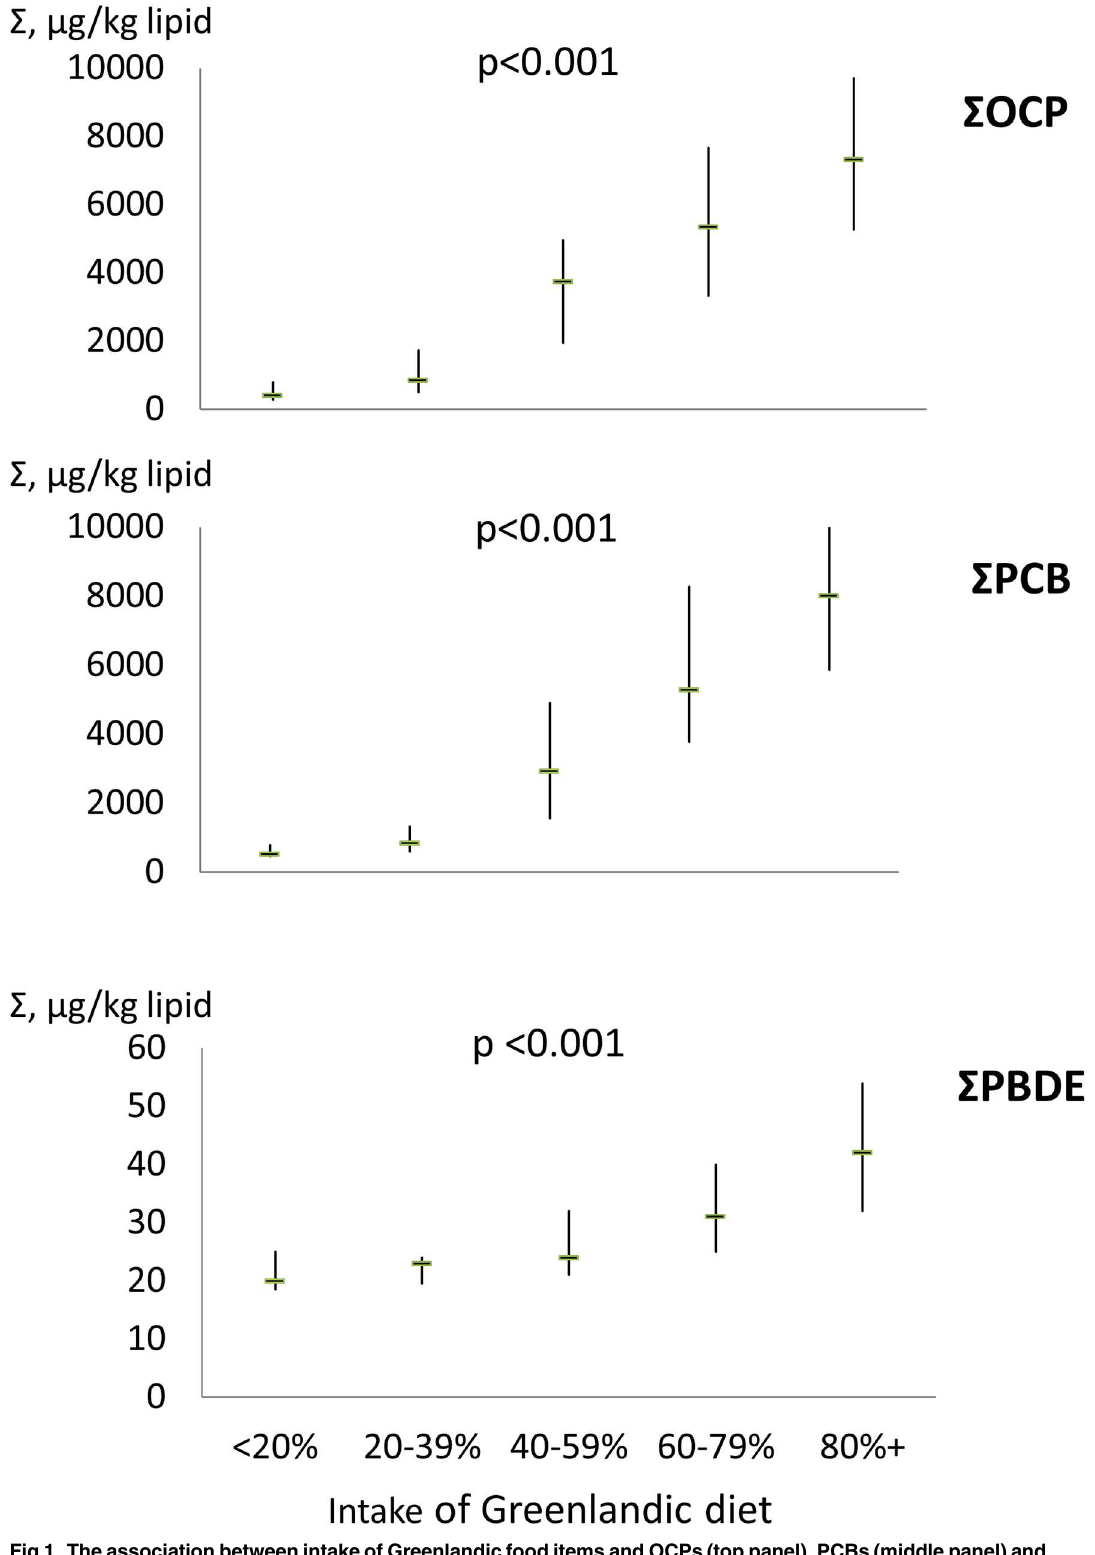
Fig 1. The association between intake of Greenlandic food items and OCPs (top panel), PCBs (middle panel) and PBDEs (bottom panel). Median levels are shown with the 25 th and 75 th percentiles. P-value is for trend.